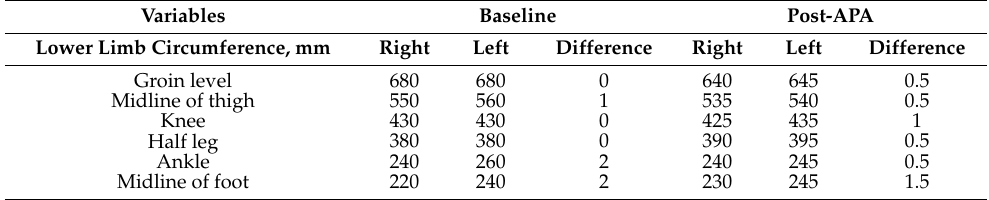
Table 3. Measurements of lower limb circumference at several anatomical points at baseline and after physical activity.